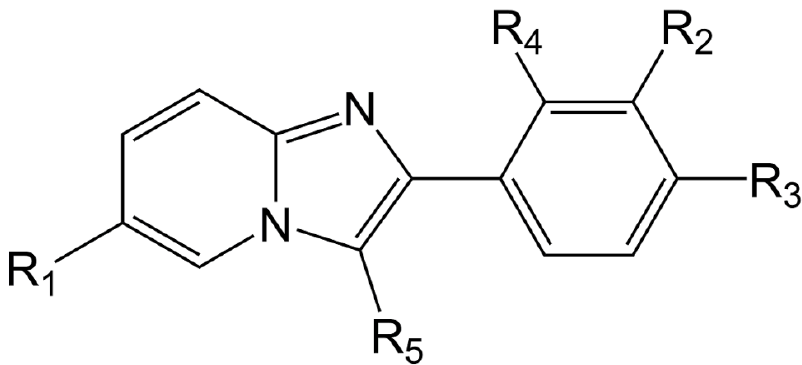
Figure 1. General chemical structure of studied molecules.